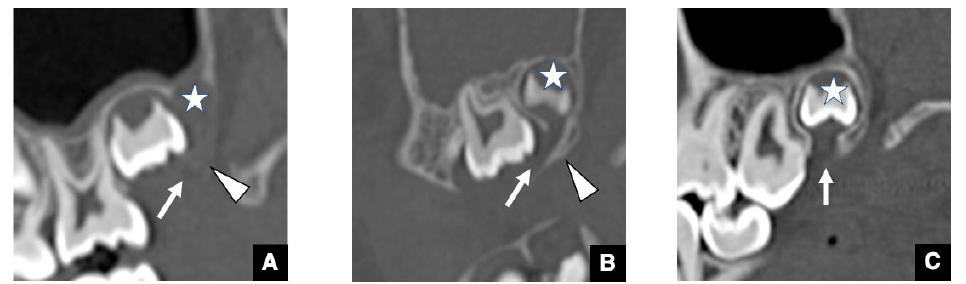
Figure 2. Representative CBCT images of various periods of GTs in maxillary molar regions with normal tooth eruption. ( A ) GT (arrow) of the maxillary third molar bud (star) in the stage of the groove-shaped GT on a parallel sectional CBCT image. The alveolar crest bone (arrowhead) on the GT is not observed because of immaturity. ( B ) GT (arrow) of the maxillary third molar (star) in the J-shape stage on a parallel sectional CBCT image. The alveolar crest bone (arrowhead) on the GT appears, and the ductal form becomes clear. Notably, the GT curves mesial and opens to the mesial tooth bud. As a result, the GT forms a J-shape. ( C ) GT (arrow) of the maxillary third molar (star) in the mature stage on a parallel sectional CBCT image. The GT runs perpendicularly from the DS to the alveolar crest.